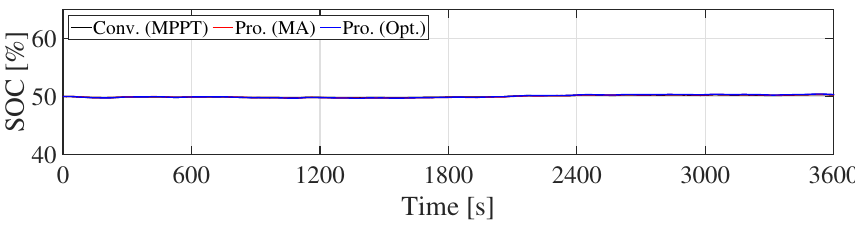
Figure 14. SOC of the Li-ion battery (Scenario 1).